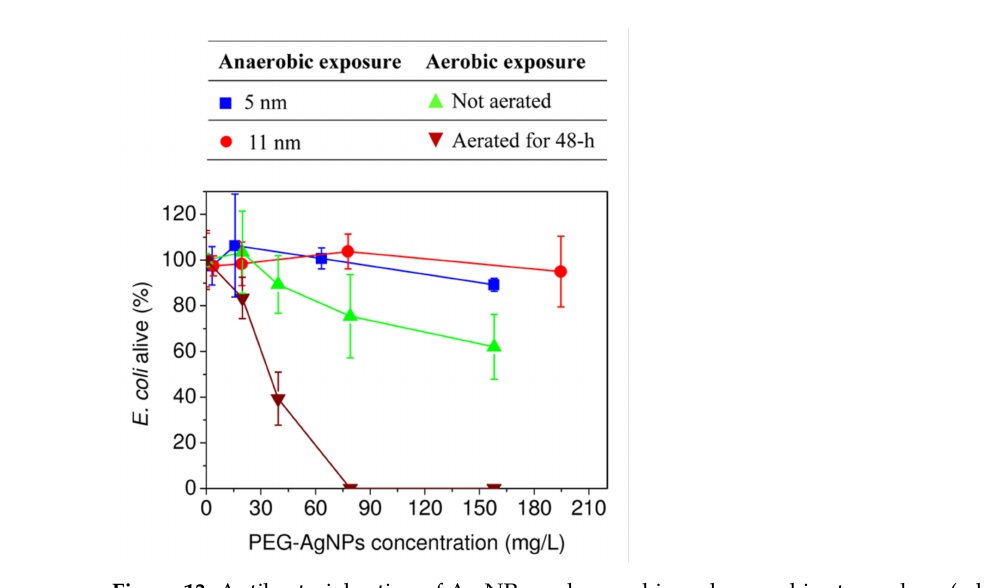
Figure 13. Antibacterial action of Ag NPs under aerobic and anaerobic atmosphere (adapted with permission from reference [121]).